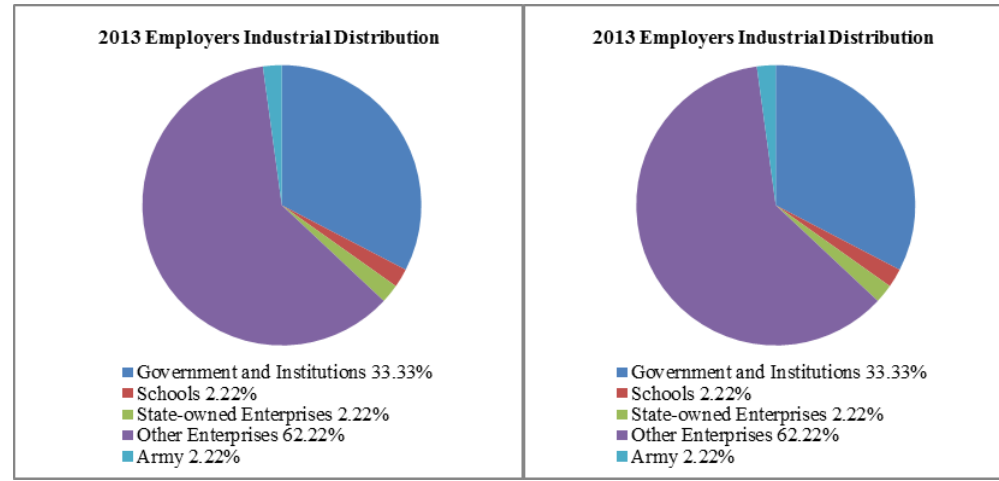
Figure5. 2004/2013 Industrial Distribution of Employers